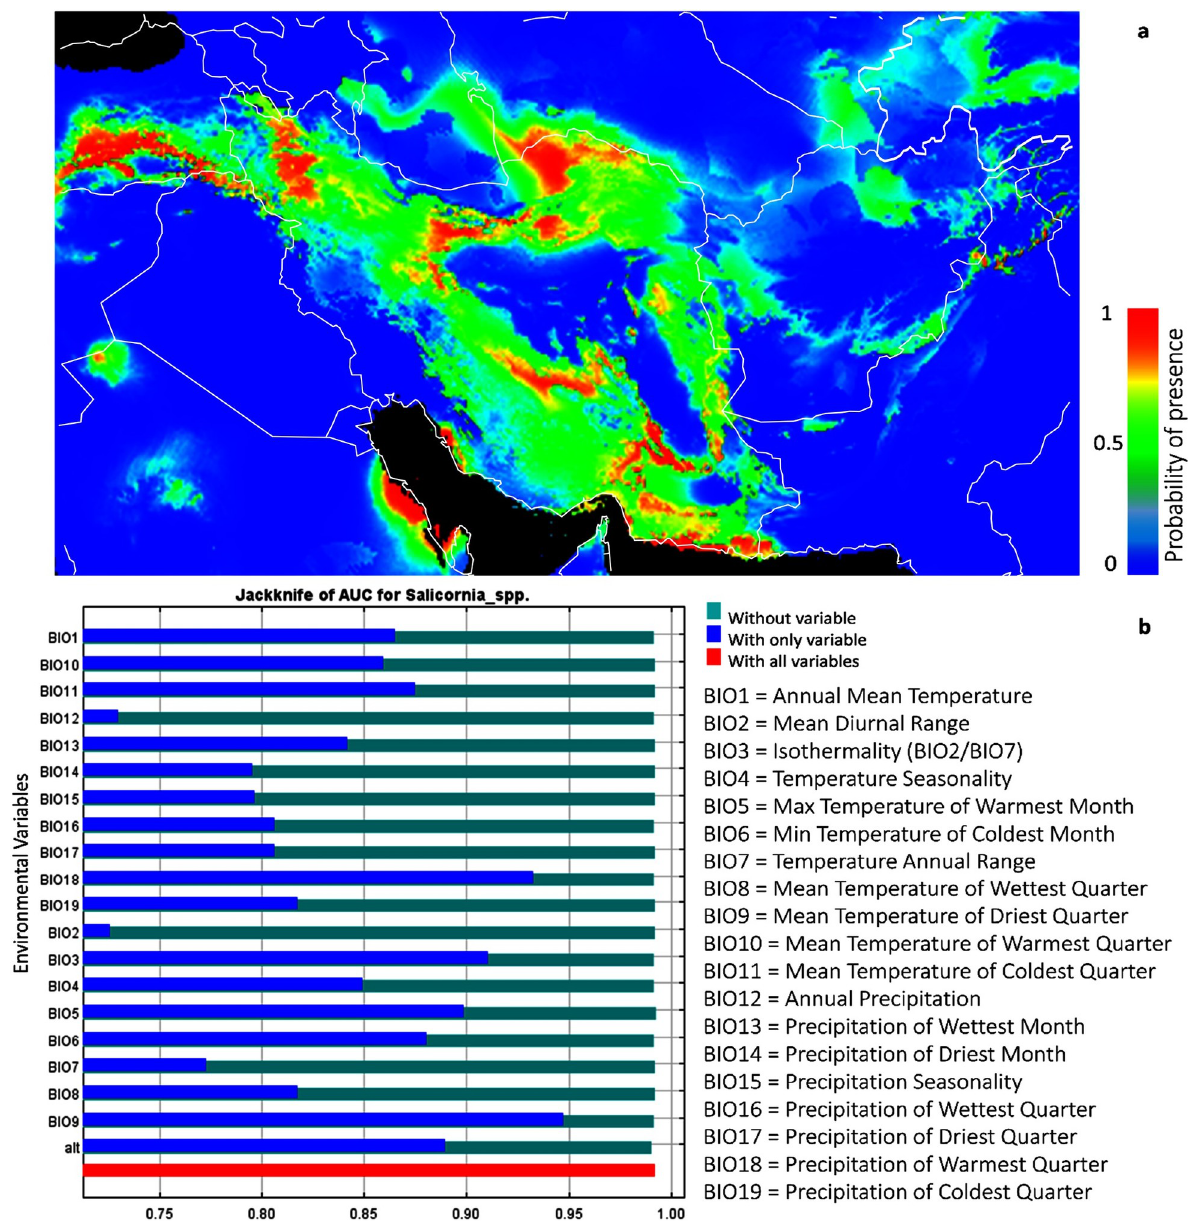
Fig 7. Geographical distribution of Salicornia in Iran (a); the probability of presence increase from blue to red, (b) the effect of climates parameters on Salicornia distribution in Iran. The map was created using free open source MAXENT software version 3.4.1 (https://biodiversityinformatics. amnh.org/open_source/maxent/).